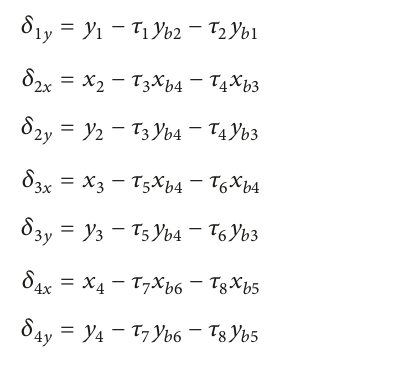
Figure 2: The dynamic transformation schematic diagram of the internal parts of the